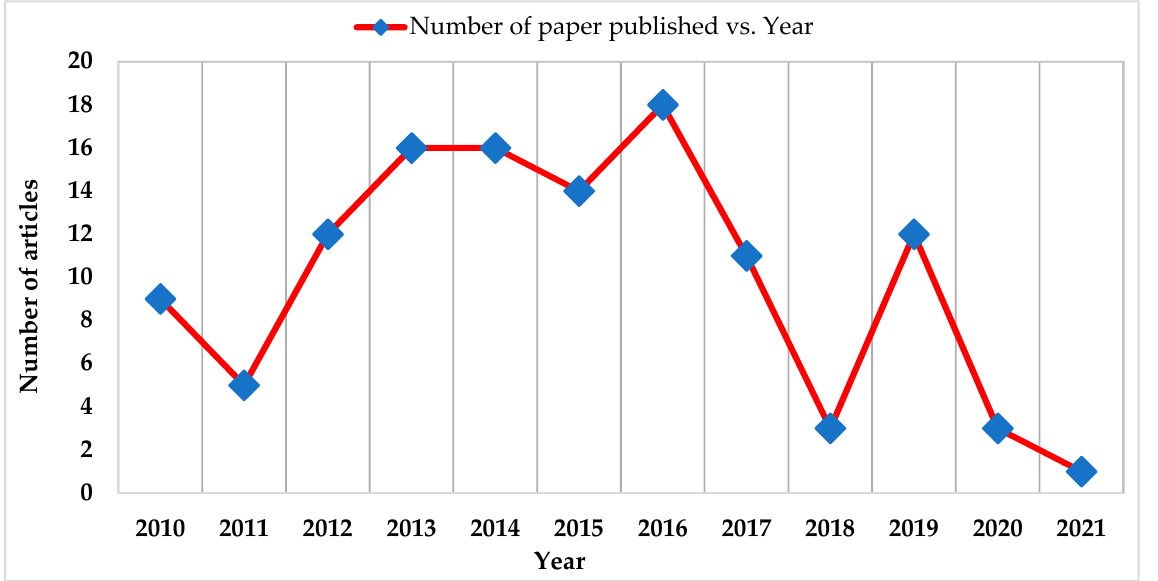
Figure 3. Distribution of 130 top cited manuscripts from 2010 to 2021.